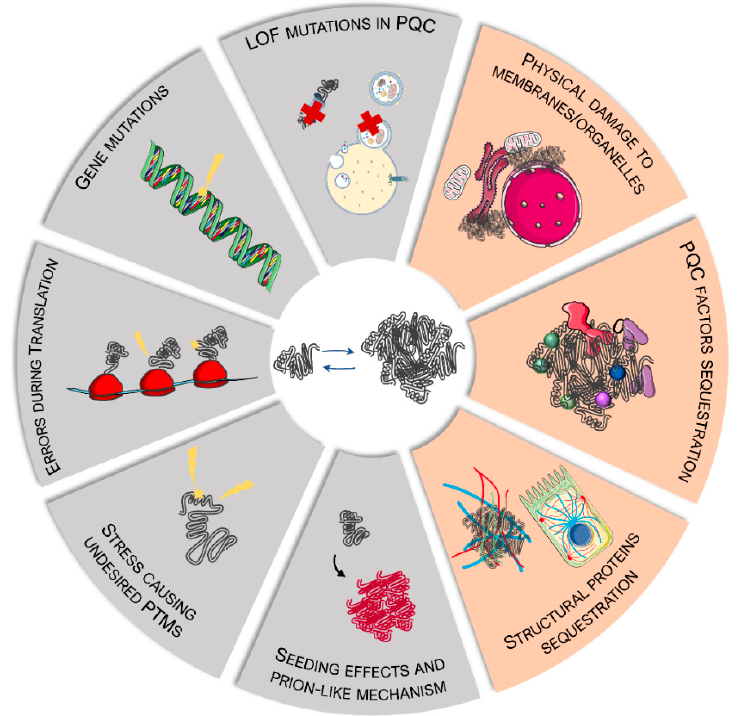
Figure 1. Mechanisms and consequences of protein misfolding and aggregation. In grey, mechanisms that directly or indirectly cause protein misfolding and accumulation into aggregates. In orange, the main damaging effects of misfolded proteins and aggregates on cell homeostasis. LOF = loss of function; PQC = protein quality control; PTMs = post-translational modifications. This